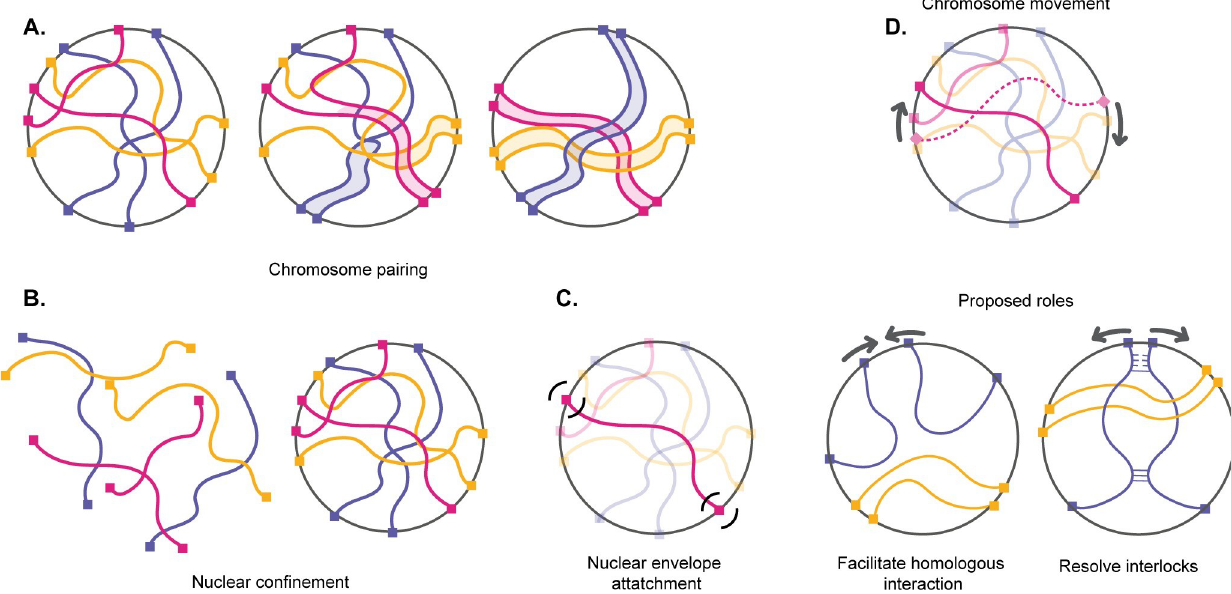
Fig 1. The physical context of meiotic pairing. (A) Cartoon schematic of chromosome pairing (B) Cartoon schematic of nuclear confinement (C) Cartoon schematic of telomere attachment to the nuclear envelope (D) chromosome movement and two proposed roles: To increase collisions between homologous loci, or to resolve interlocks by breaking apart problematic pairing